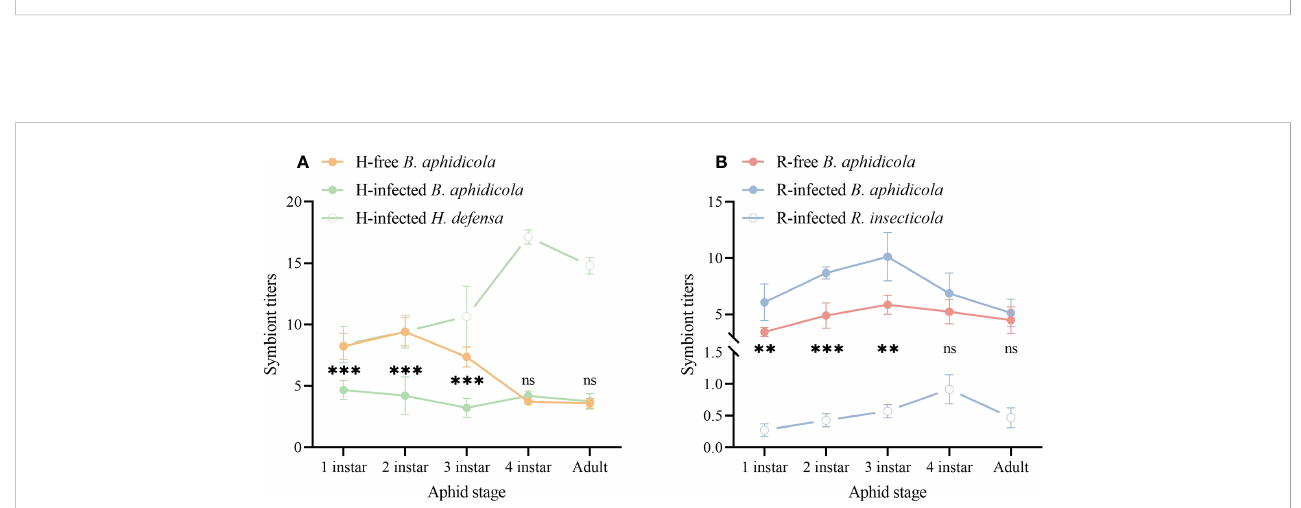
FIGURE 5 Symbiont titers of different aphid strains. (A) B. aphidicola and H. defensa titers. (B) B. aphidicola and R. insecticola titers. The asterisk indicates signi fi cant differences in B aphidicola titers between the S-symbiont-infected aphid strains and its equivalent S-symbiont-free aphid strains, based on the t -test for two-sample comparison: ** P <0.01, *** P <0.001, and ns nonsigni fi